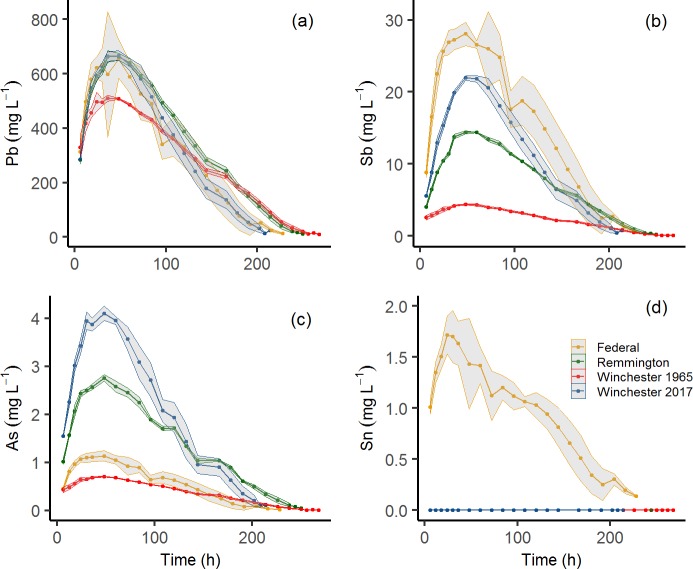
Average Pb, Sb, As, and Sn concentrations for all four shot types.(a) Pb, (b) Sb, (c) As, and (d) Sn. Winchester and Remington shot are not shown in (d) because Sn was not detected at any time point. Shaded areas represent the standard deviation of the replicate samples (n = 6 for Federal shot, n = 3 for all other shot types).